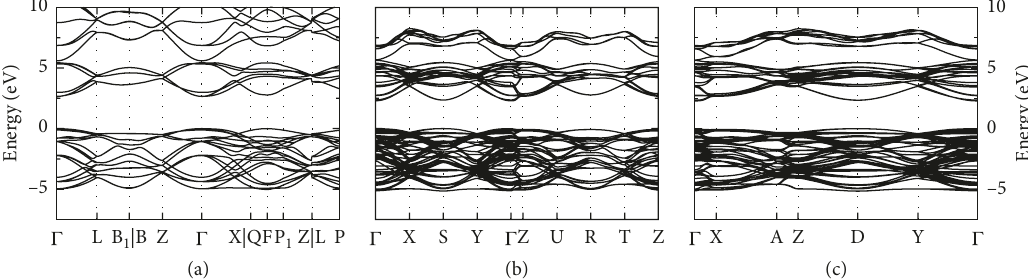
Figure 5: NaNbO 3 electronic band structures for the crystalline phases at room temperature and below calculated using the PBEsol functional revised for solids [18]. The electronic band structures for (a) the rhombohedral R 3 c phase (SG 161), (b) the orthorhombic Pbcm phase (SG 57), and (c) the monoclinic Pm phase (SG 6) are shown. Zero energy has been rescaled to the valence band maximum.